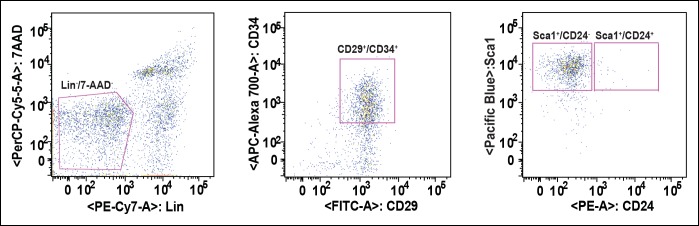
Strategy of FACS-based purification of adipogenic progenitor cells.Adipogenic progenitor cells were sorted from the adipogenic progenitor specific maker-labeled SVF suspensions with AriaII (Becton Dickson) cell sorter, and the purity of sorted cells verified as >95% by rerunning the sorted population.